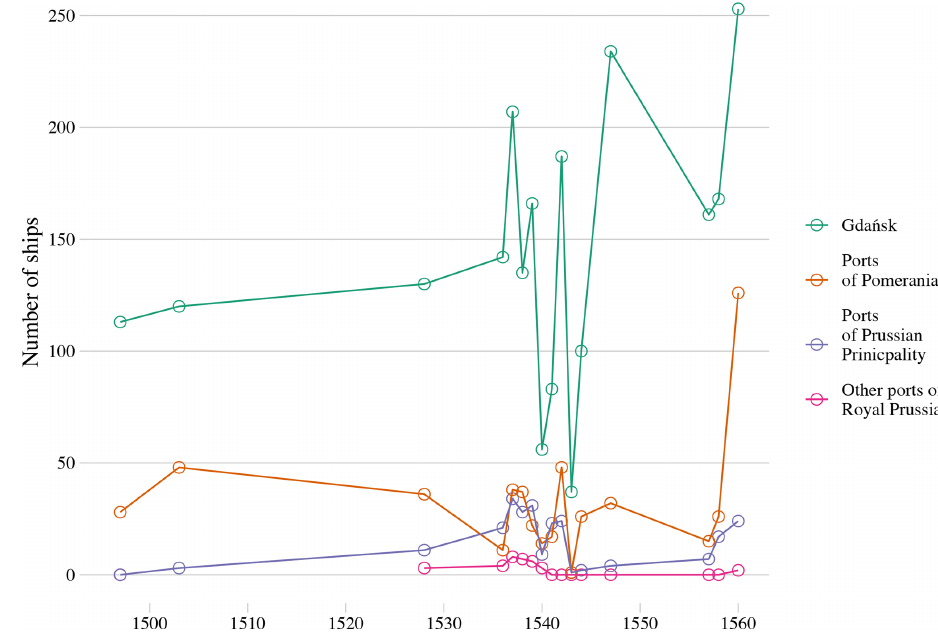
Figure 16. Ships from Polish and Prussian ports registered in the Sundtolls. Source: Ellinger and Korst (1906).